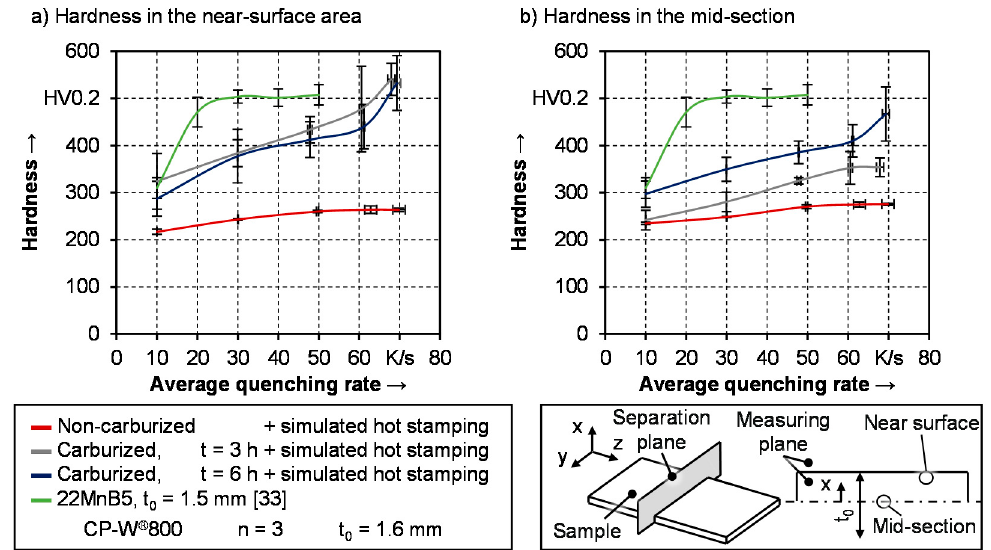
Figure 8. Development of Vickers hardness in the ( a ) near the edge and ( b ) in the mid-section as a function of the average quenching rate.